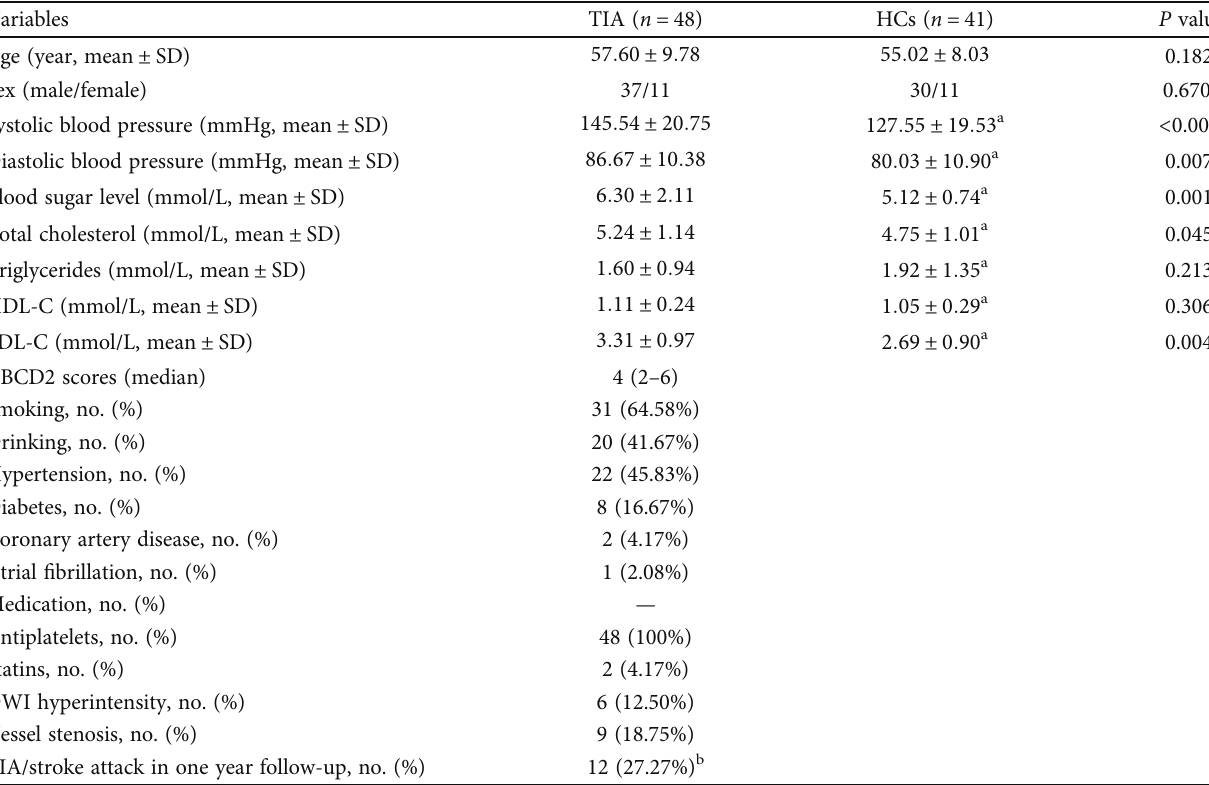
Table 1: Demographic and clinical information of all participants.